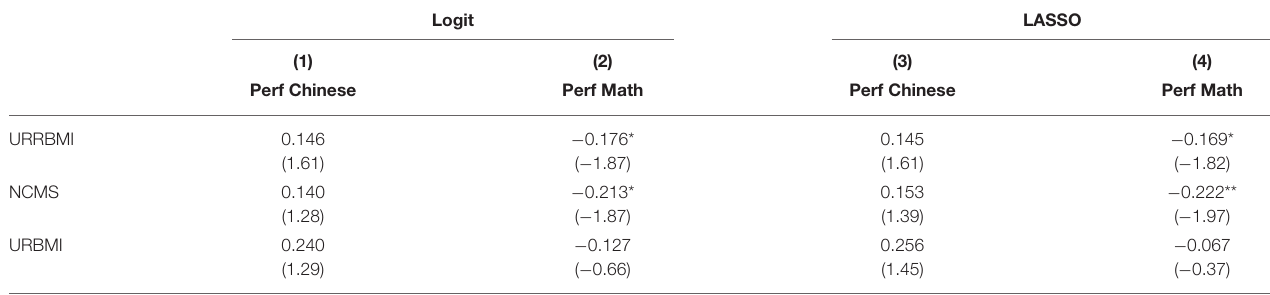
TABLE 3 | Logit and lasso regression.